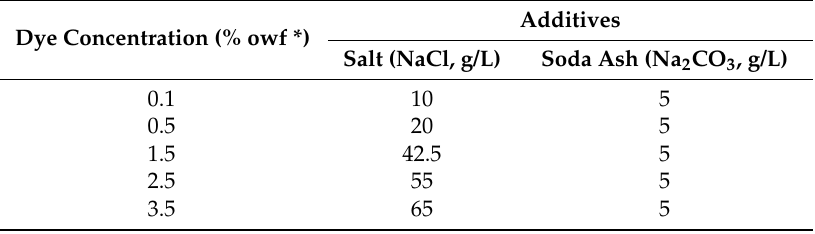
Table 2. Dye recipe for calibration dyeing.